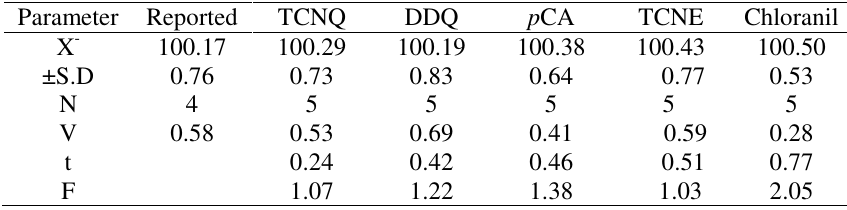
Table 6 . Determination of pregabalin in Lyrica ® capsules by the proposed and